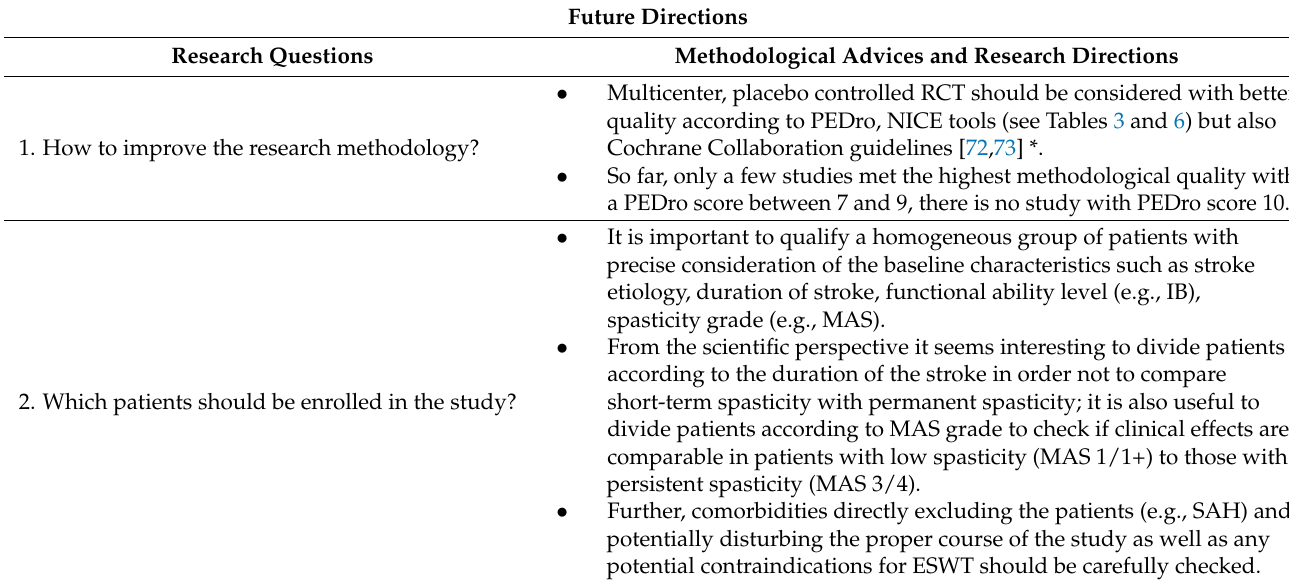
Table 8. Research questions and suggestions for future research